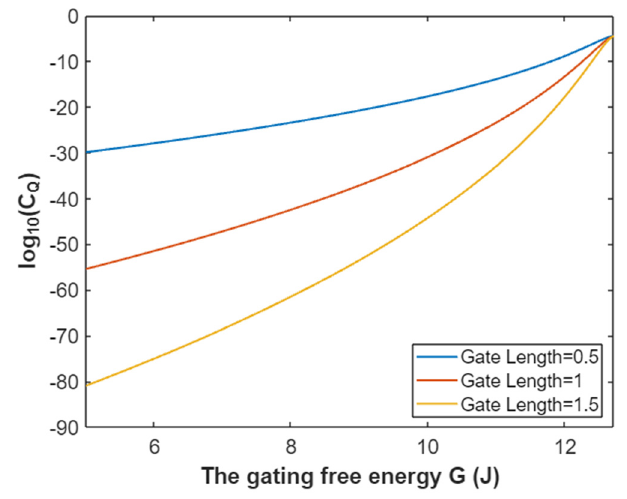
Figure 28. The relationship between gating free energy and the common logarithm of quantum conductance of a single potassium channel for intracellular potassium ions at membrane potential of 0.087 V and over a gating free energy range from 5 J to 12.72 J.